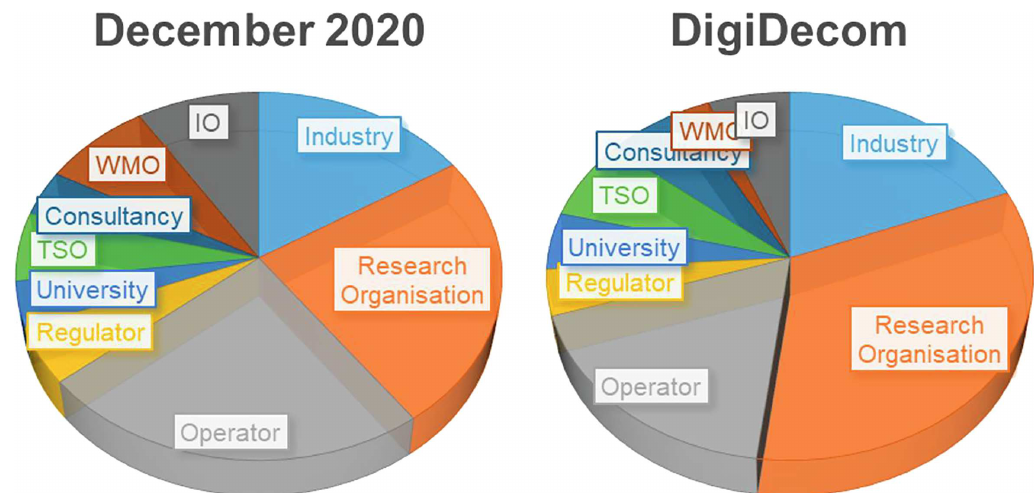
Fig. 9. Pie charts of the profiles of the participants to the two workshops organised for the gap